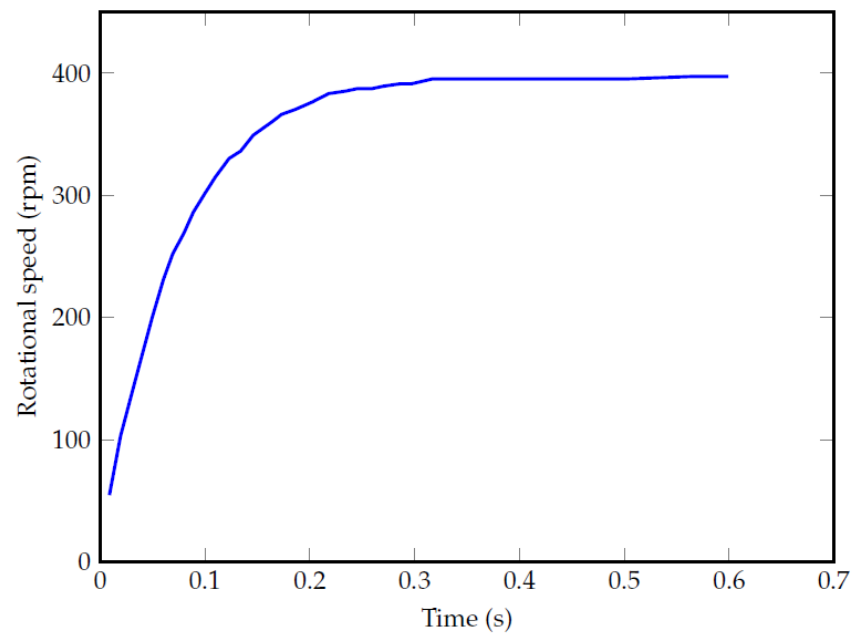
Figure 9. Example of rotational speed vs. time, P in = 2.0 bar (absolute